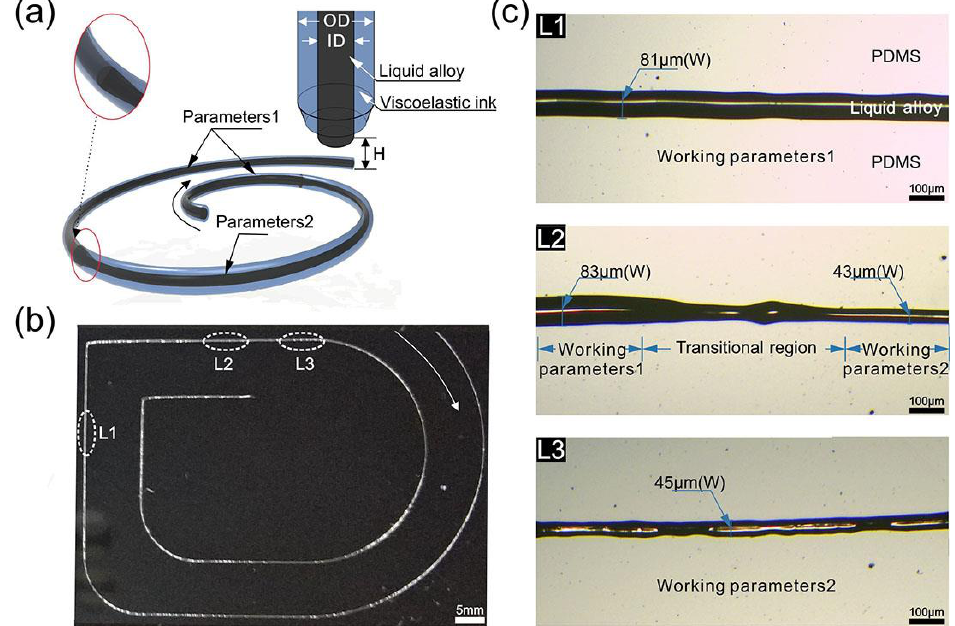
Figure 1. ( a ) Schematic illustration of liquid ally cable with different diameters during printing process; ( b ) photograph of printed cable with different diameters of liquid alloy; ( c ) optical images of different segments of the cable shown in Figure 1b: the diameters of liquid alloy in L1 and L3 are about 81 μm and 45 μm, respectively. L2 is the transitional region between L1 and L3. Working parameters 1: The moving speed of the stage (V P ) is 25 mm/s, the flowrate of liquid alloy and PDMS are 8 μL/min (Q ID ) and 80 μL/min (Q OD ), respectively. Working parameters 2: The moving speed of the stage is 50 mm/s, the flowrate of liquid alloy and PDMS are 4 μL/min and 80 μL/min, respectively. The distance between the outle t of coaxial nozzle and substrate (H) is about 10